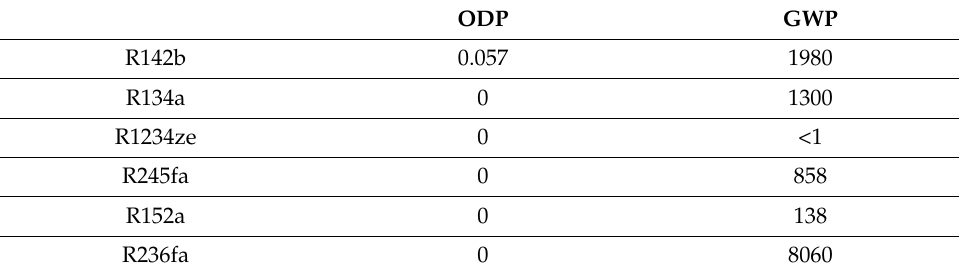
Table 4. The ODP and GWP of different refrigerants.